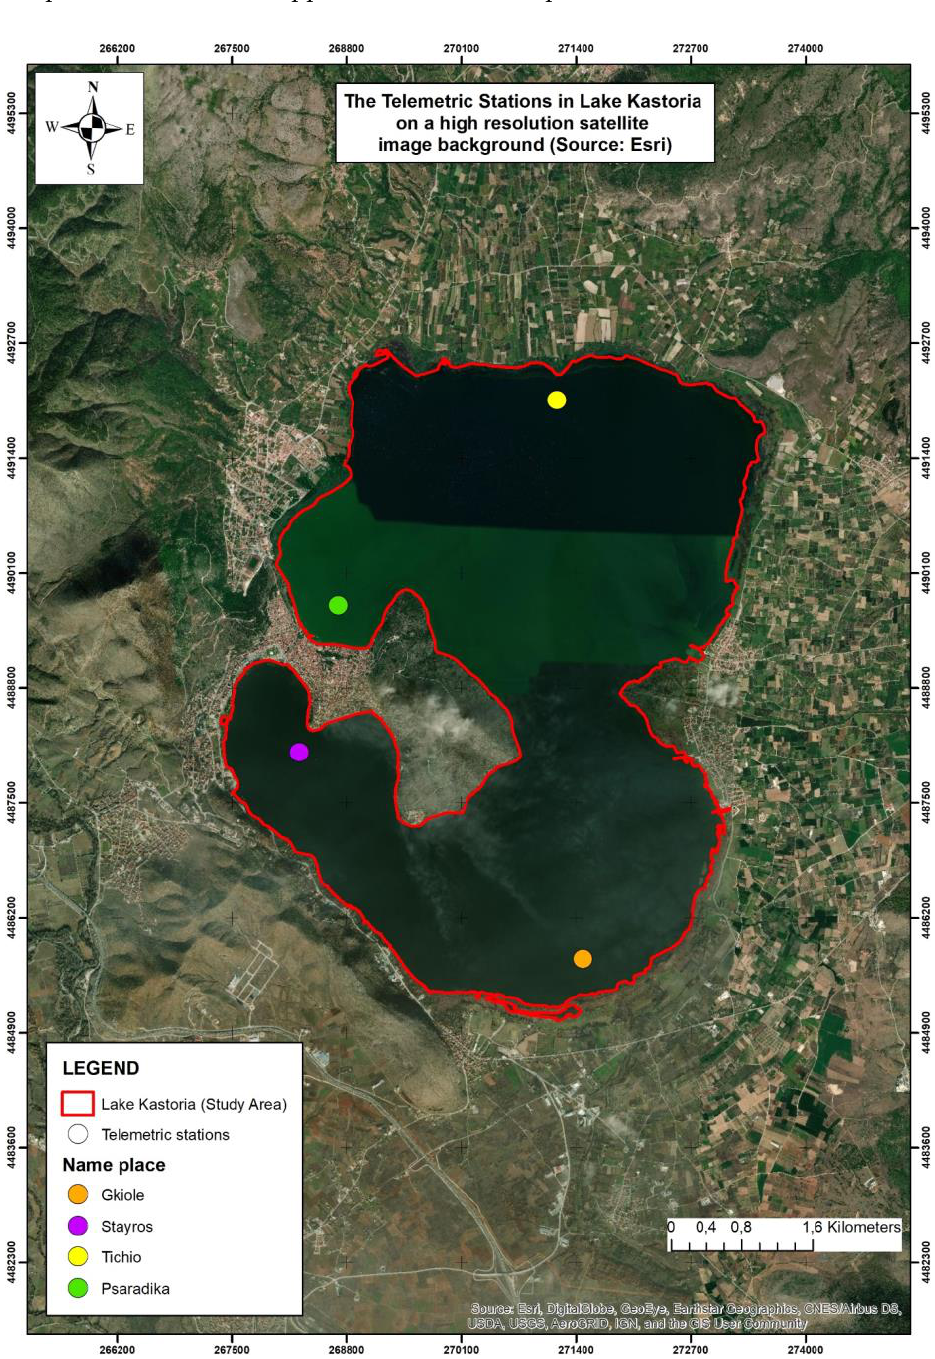
Figure 1. The position of telemetric stations in Lake Kastoria [9].